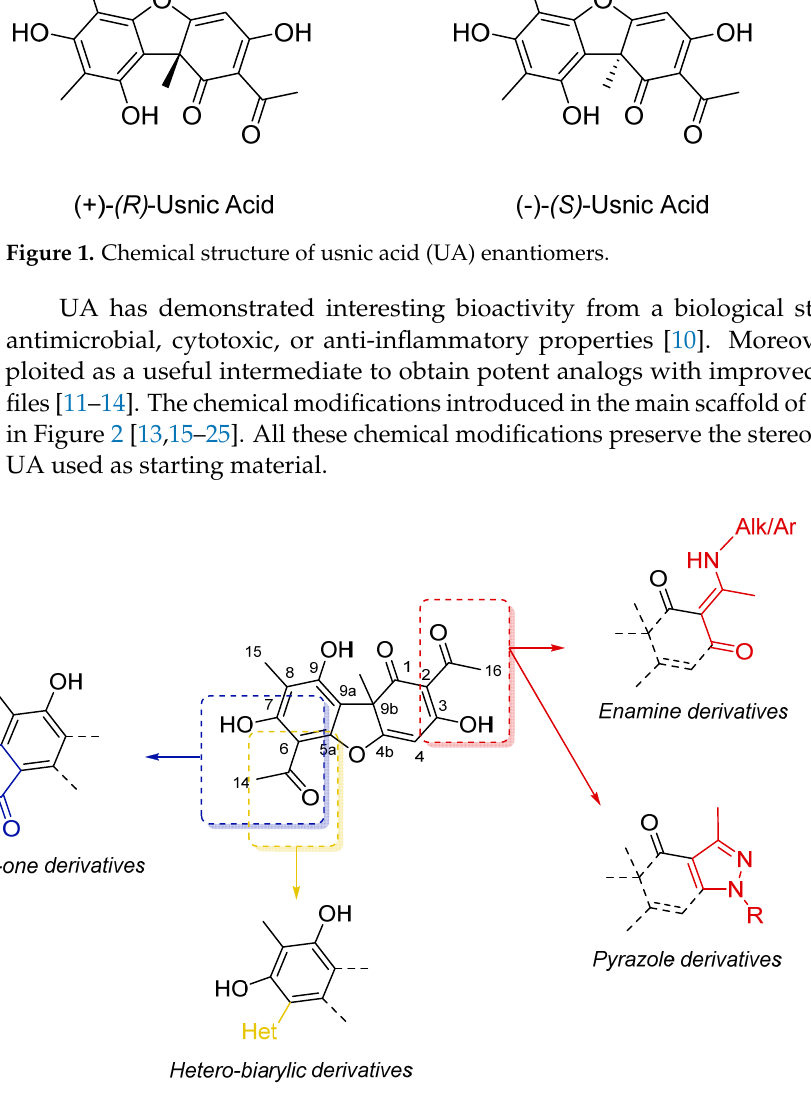
Figure 2. Chemical modifications of the main core scaffold of UA apported in the derivatives described in the literature [13,15–25].